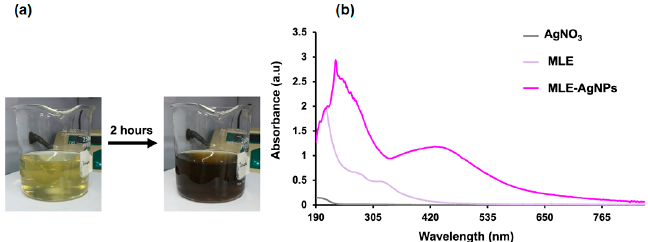
Figure 1. Characterization of AgNPs using white mulberry leaf extract (MLE-AgNPs). Changing color of the reaction mixture after 2 h incubation time ( a ); UV–Vis spectra of MLE-AgNPs compared with either silver nitrate solution (AgNO 3 ) or MLE alone ( b ).